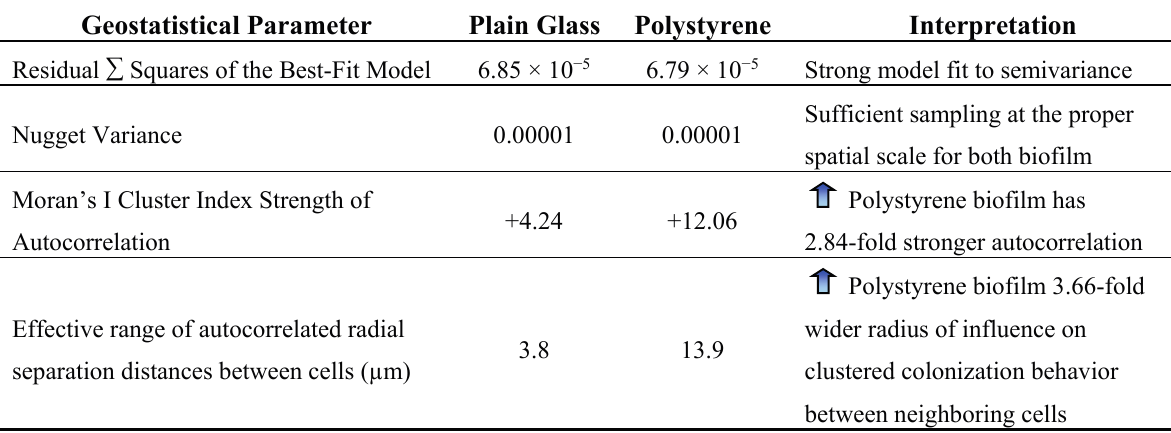
Figure 4. Geostatistical isotropic semivariograms of autocorrelated, clustered colonization behavior of the microbes in the river biofilm landscapes developed on ( a ) control glass and ( b ) polystyrene. Table 3. Geostatistical analysis of the spatial autocorrelation of clustered colonization behavior among individual cells in the aquatic biofilm landscapes on plain glass and polystyrene